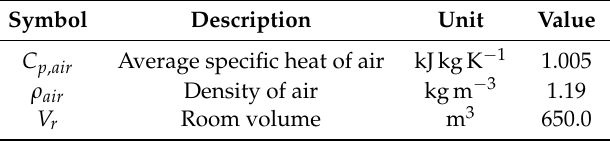
Table A1. Thermal parameters common to all shelter.